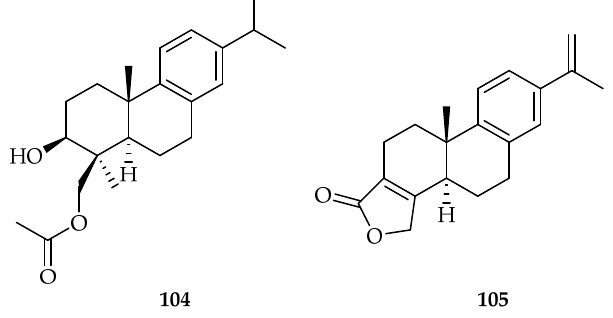
Figure 43. Structures of nepetaefolin F 104 [66] and nepetaefolin G 105